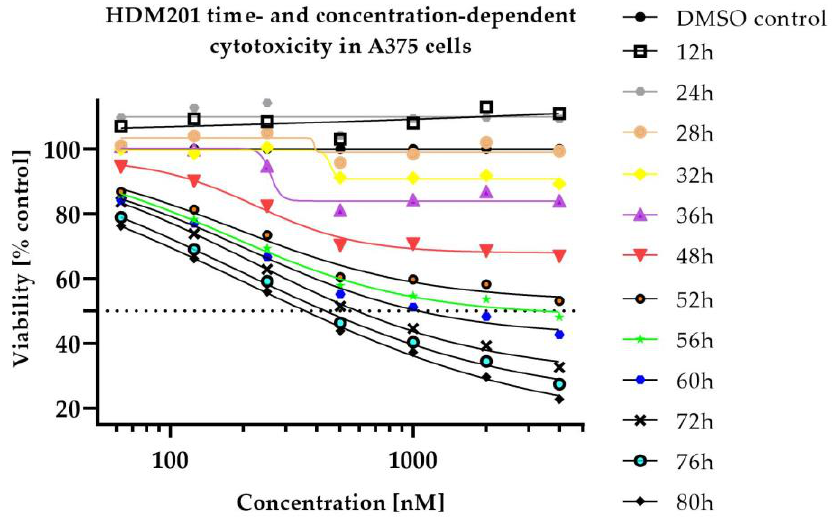
Figure 1. Time- and dose-dependent cytotoxicity of HDM201 in A375 cells. Mean from n = 3 (RealTime-Glo assay).